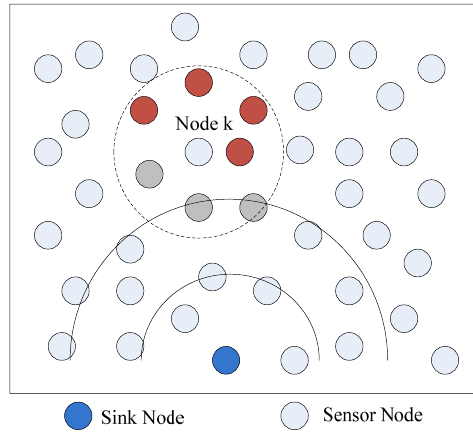
Figure 11. Meaning of p . The spreading process is shown by full curve. The communication radius of Node k is presented by circle